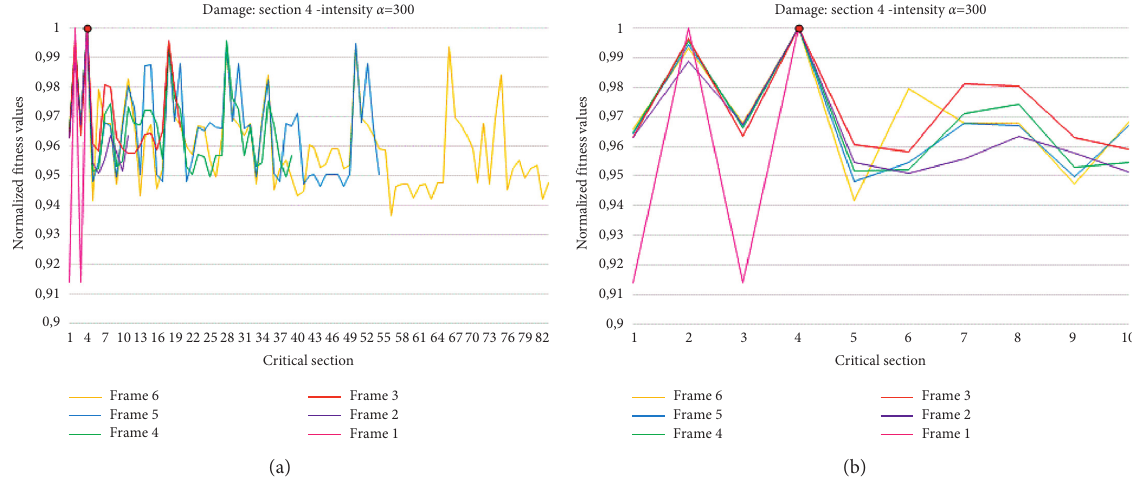
Figure 12: Normalized fitness values for damage with intensity α � 300 located in section 4 (a) and a zoom (b) for all the analysed frames.